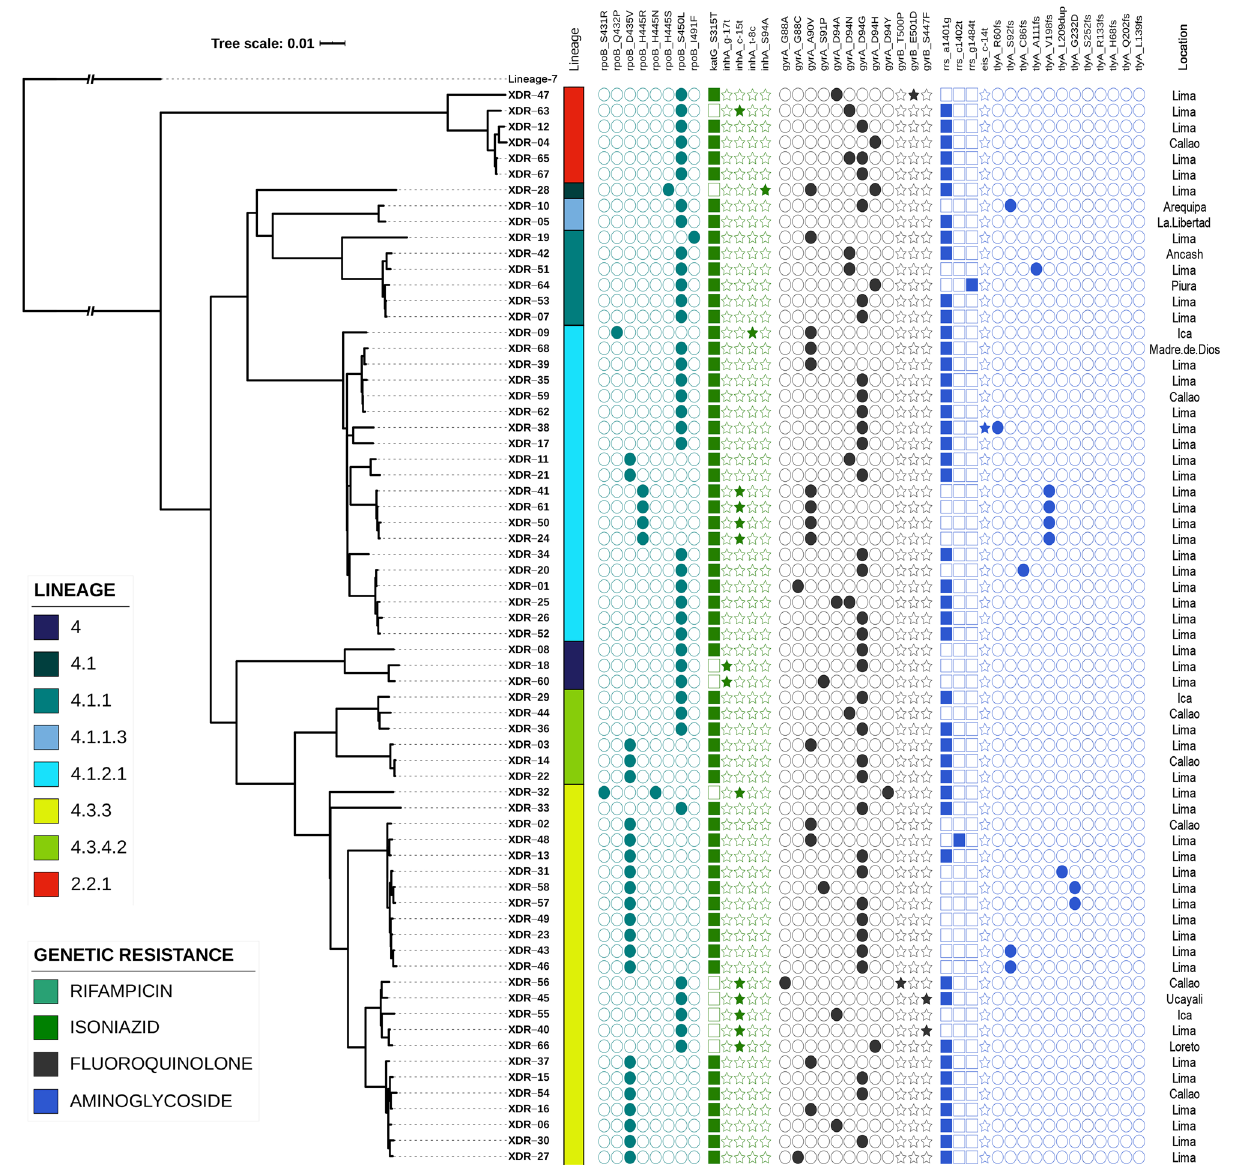
Figure 2. Maximum likelihood phylogenomic tree from 68 genomes of Peruvian XDR-TB strains. The tree was based on 6,076 genome-wide SNPs. More than 74% of nodes presented a support bootstrap ≥ 70%. All nodes outlining the main subdivisions of lineages and sublineages were supported by 100% bootstrap values. Lineages are represented near the tip names. Mutations are represented by filled (presence of mutation) or empty (absence of mutation) icons. The figure was created using iTOL v5 (https:// itol. embl.